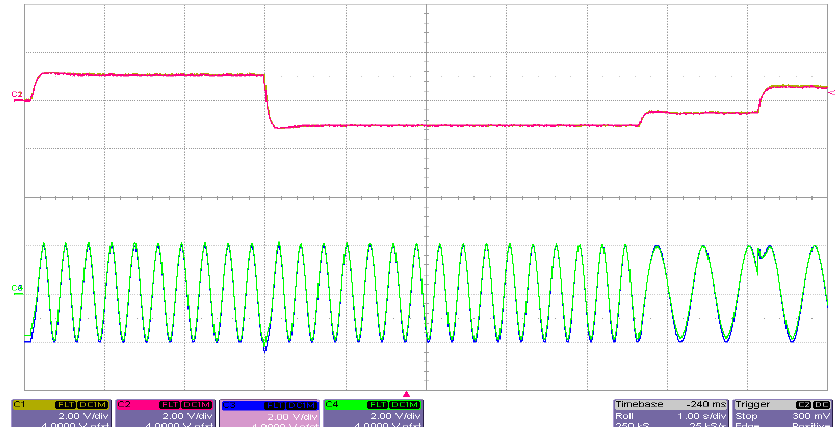
Figure 8. Experimental result: speed sensorless control using estimated rotor speed when speed sensor fails—speed reversal to ±100 rpm, then step changes of load torque from 0 to − 5 Nm and from –5 to 0 Nm. Measured (yellow) and estimated (red) rotor speed, torque producing stator current (green). Scales: speeds—200 rpm/div; currents—5 A/div; time—500 ms/div.